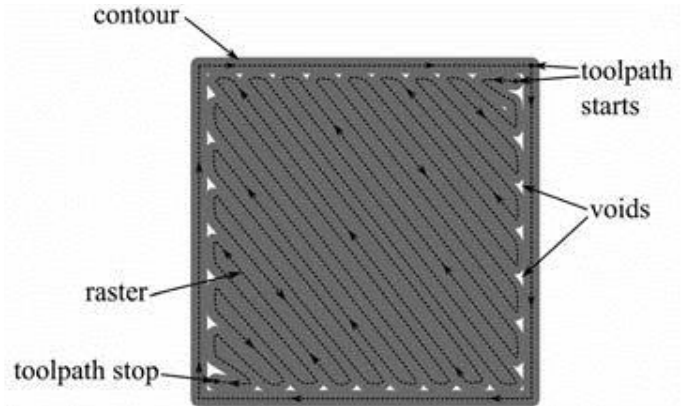
Figure 7. Sub-perimeter voids. Reprinted with permission from [34], 2015, Emerald Publishing, Bingley, UK.